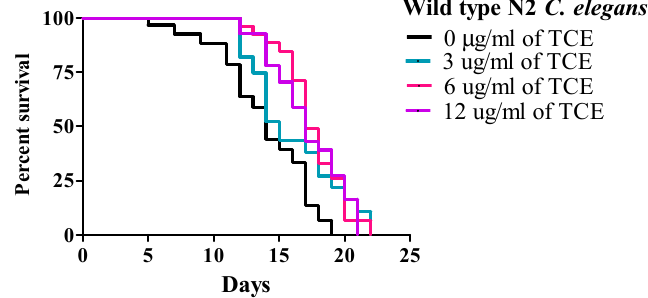
Figure 1. Tart cherry extract (TCE) extends lifespan in Caenorhabditis elegans . Treatment with 6 µ g / mL (pink) and 12 µ g / mL (purple) TCE increased mean lifespan (MLS) in wild type (N2) C. elegans ( p < 0.05) by 16.83 ± 0.77 and 16.73 ± 0.67 days, respectively compared to control or no treatment (0 µ g / mL, MLS 13.31 ± 0.61 days, black) or 3 µ g / mL TCE (blue, MLS: 14.92 ± 0.58 days) grown at 20 ◦ C. Each lifespan experiment was repeated at least three independent times with similar results.